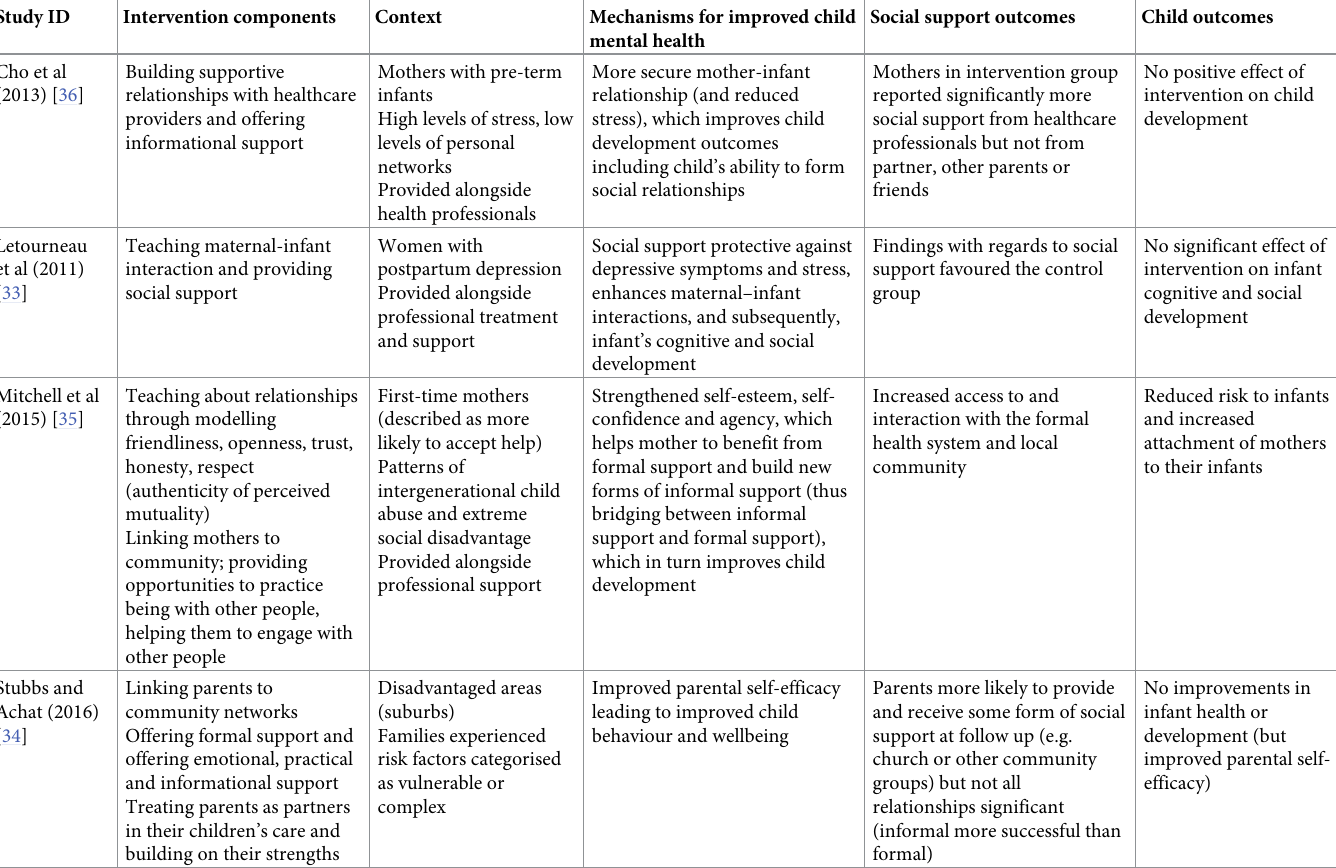
Table 1. Information about programme theories and findings from included studies concerned with infants (0–2